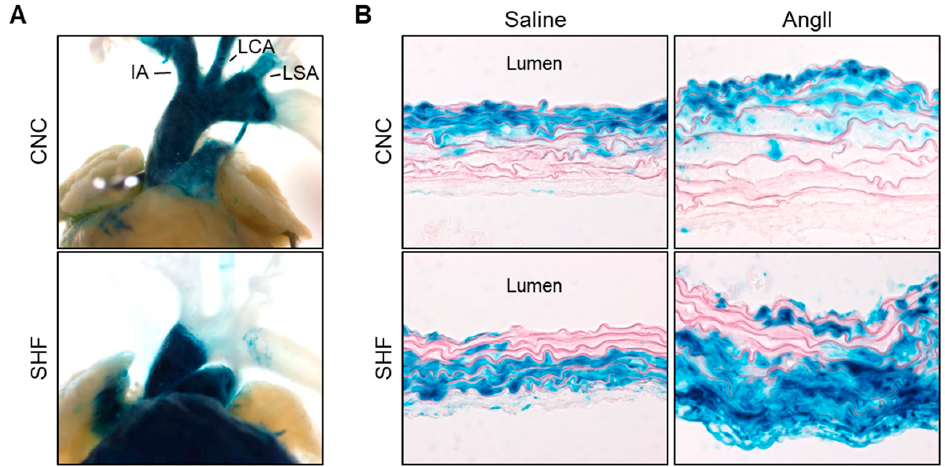
Figure 1. Embryonic origins of SMCs in the ascending aorta. Representative images of X-gal-stained aortic ( A ) tissues and ( B ) sections from Wnt1-Cre and Mef2c-Cre ROSA26R LacZ mice. Blue color indicates the distribution of cells driven by either Cre. CNC indicates cardiac neural crest; SHF, second heart field; IA, innominate artery; LCA, left common carotid artery; LSA, left subclavian artery. Images are cited from [30,32] with permission from Wolters Kluwer Health (2022). SHF-derived cells were initially mapped using avian systems [48]. A fluorescent dye was microinjected into the SHF of chick embryos and the stained cells were tracked. SHF-